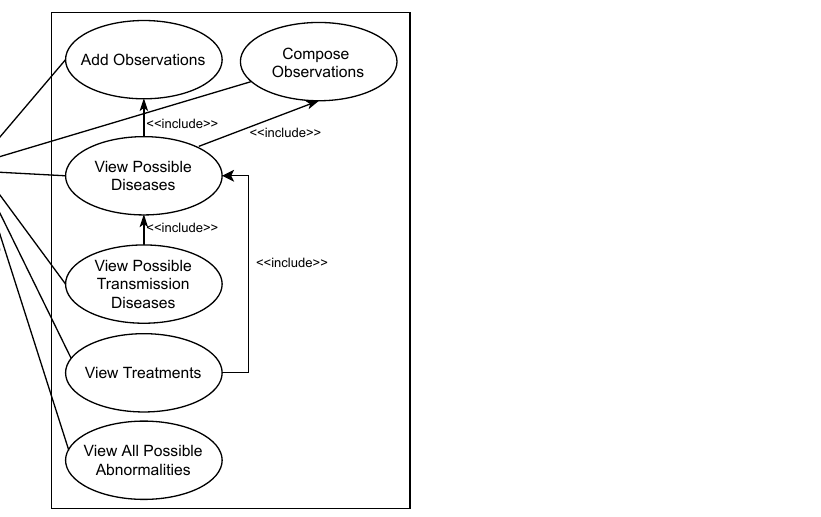
Figure 3. The RiceMan use case diagram representing six use cases of the proposed RiceMan system and three actors (i.e., farmer, agronomist, and scholar).